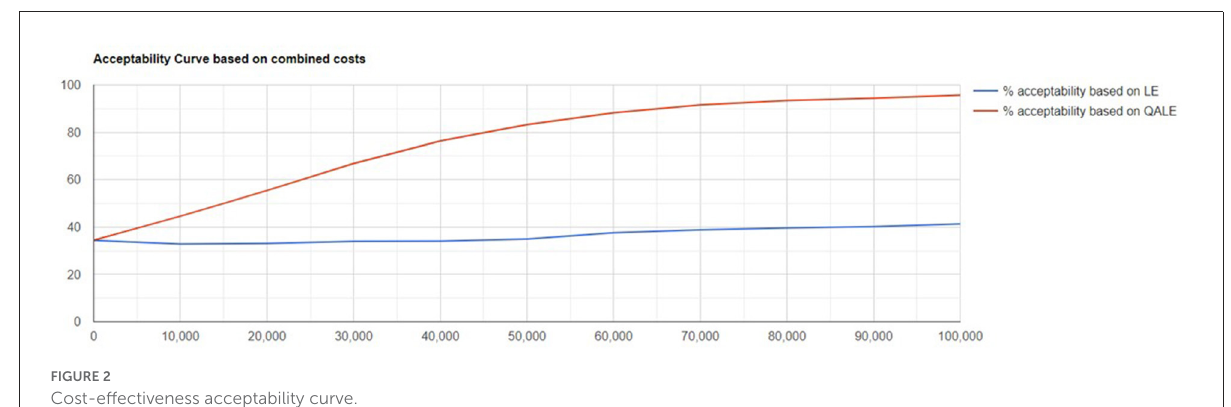
FIGURE2 Cost-effectiveness acceptability